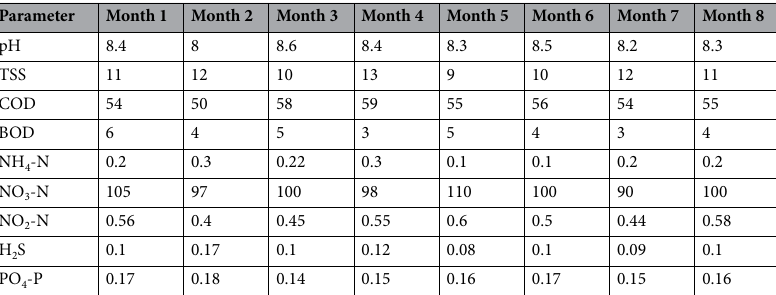
Table 5. Pilot EN-MBBR effluent concentration of pollutants after 8 months of operation.